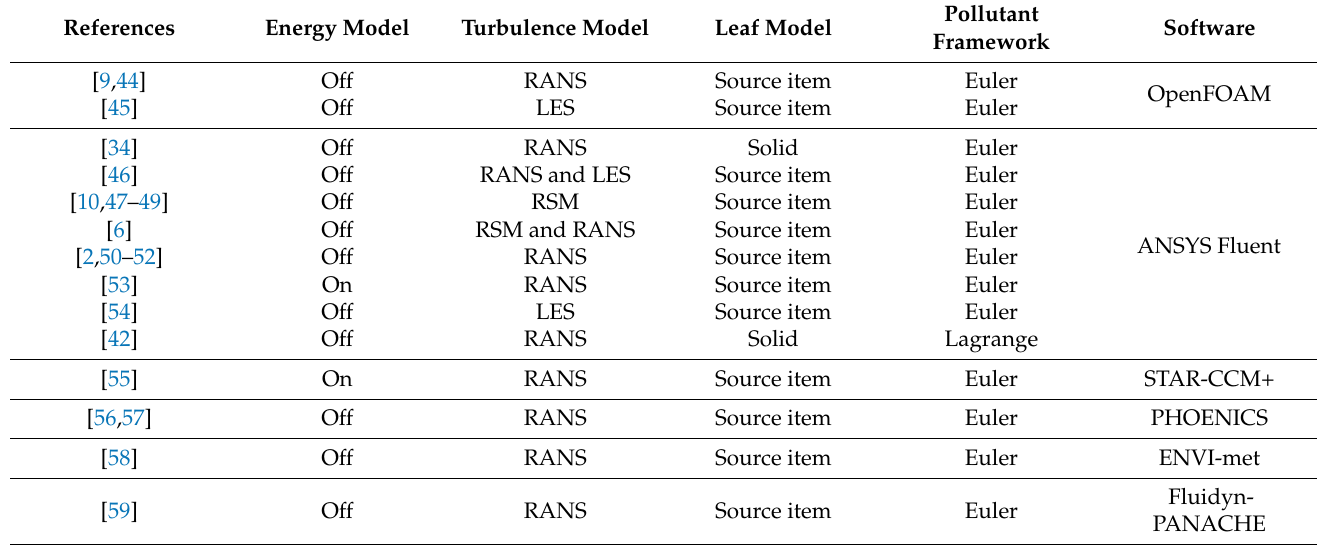
Table 1. Mathematical models adopted by different